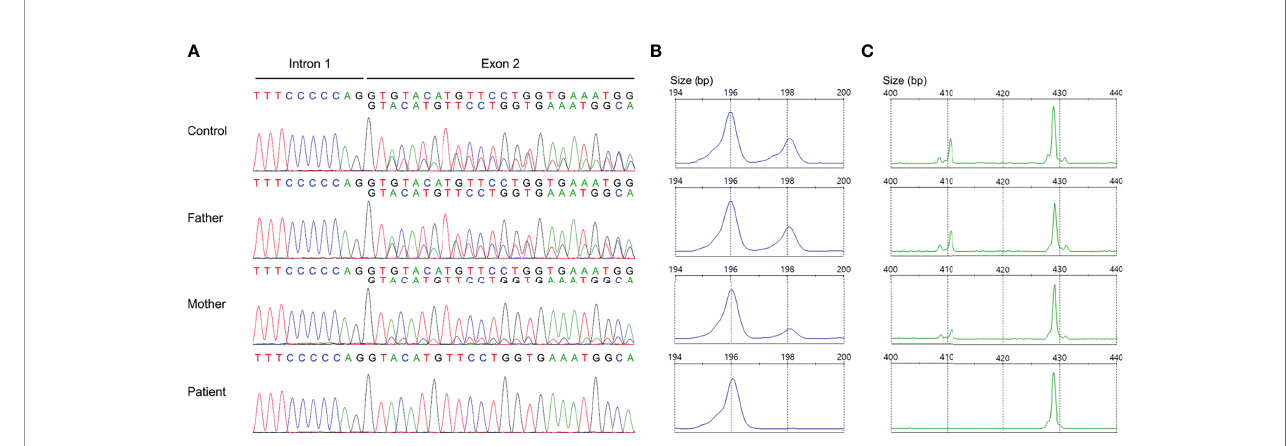
FIGURE 3 | Validation of GT-deletion ( D GT) in NCF1 . (A) Coampli fi cation of NCF1 and its pseudogenes at intron 1/exon 2. Overlapping peaks of GTGT-containing NCF1 and D GT-containing pseudogenes were observed in the control and parents. The patient only had a product of NCF1 pseudogenes, indicating a D GT in NCF1 (NM_000265.7: exon 2: c.75_76delGT: p.Tyr26Hisfs*26). (B) D GT gene scan. The fragments of NCF1 and its pseudogenes were depicted by the 198-bp peak and 196-bp peak respectively. A normal ratio of 2:4 was identi fi ed in the control and father, re fl ecting two copies of NCF1 per four copies of pseudogenes. Meanwhile, the mother had a ratio of 1:5, signifying the carrier of D GT in NCF1 . Only a single peak of NCF1 pseudogenes was observed in the patient. (C) 20-bp gene scan. The 411-bp-peak and 429-bp-peak represented the fragments of NCF1 and its pseudogenes respectively. Results from 20-bp gene scan corroborated the ratios from D GT gene scan. The patient was con fi rmed to have a biallelic loss of NCF1 , in which one allele was included in the Williams-Beuren syndrome (WBS) deletion while another allele harbors a D GT. bp, base